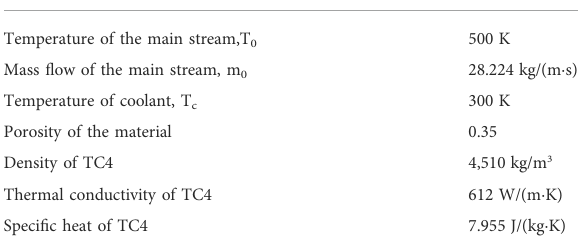
TABLE 2 Boundary conditions. Boundary